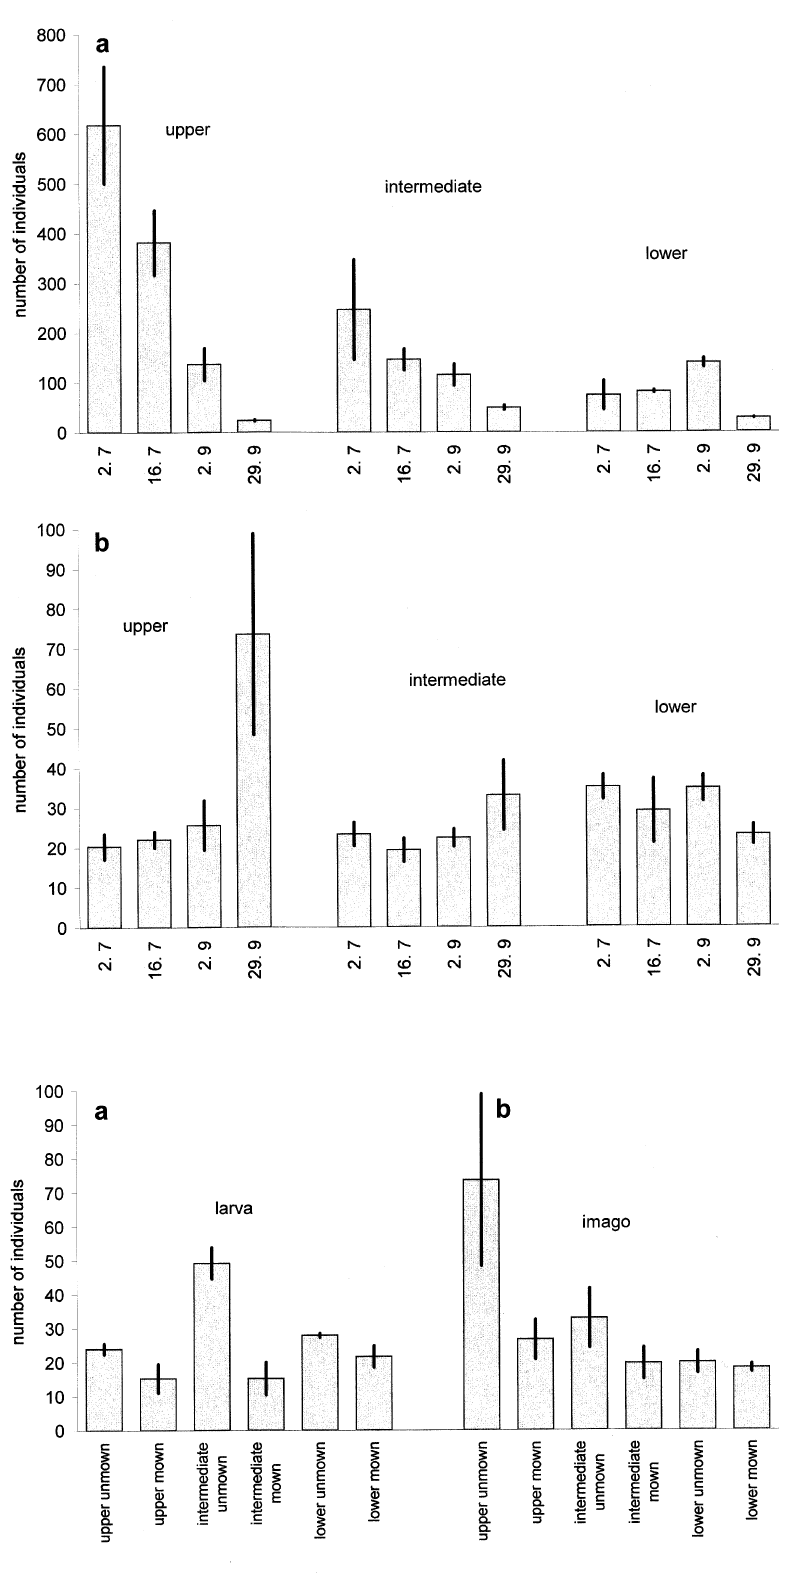
Fig. 5. Average number and stand- ard error of Auchenorrhyncha larvae (a) and imagoes (b) in the different plots in 29. 09. 1997, from suction